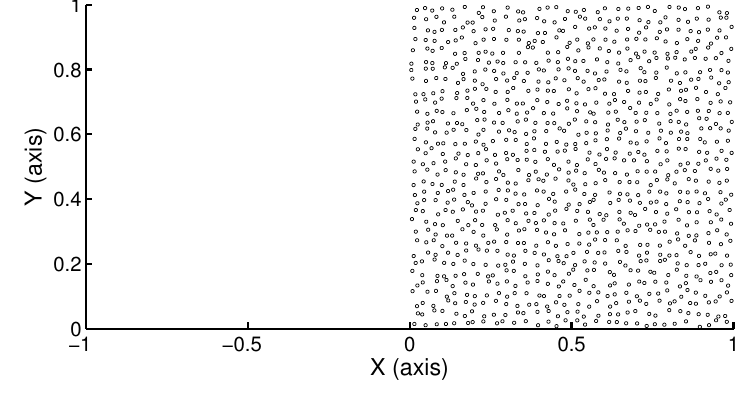
∪ Ω = [ − 1 , 0] × [0 , 1] represents a Figure 1. Illustration of the domain Ω = Ω , where Ω 1 2 1 = [0 , 1] × [0 , 1] contains a cell-seeded scaffold. The region on the nutrient-rich bath and Ω 2 right ( Ω ) contains 1024 cells randomly distributed. Each cell is represented by a disc with 2 a radius corresponding to (cid:15) = 5 µm.